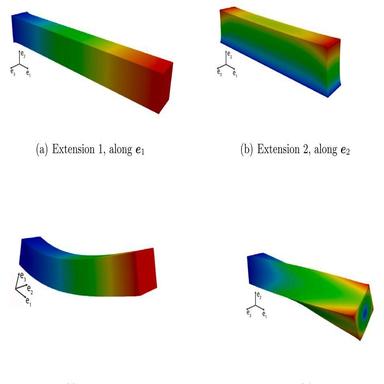
The four boundary value problems for generation of synthetic data.